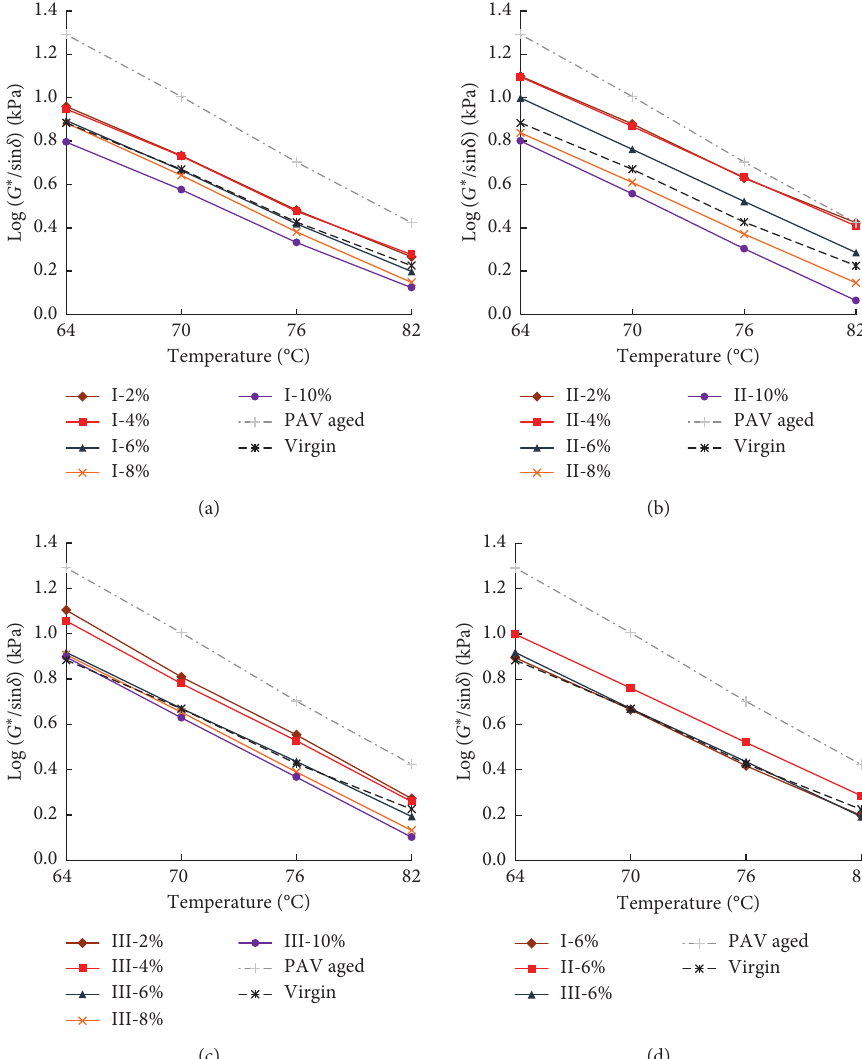
Figure 4: Variations of rutting factors with the types and dosages of rejuvenators. (a) Rejuvenator Type I; (b) rejuvenator Type II; (c) rejuvenator Type III; (d) rejuvenator dosage is